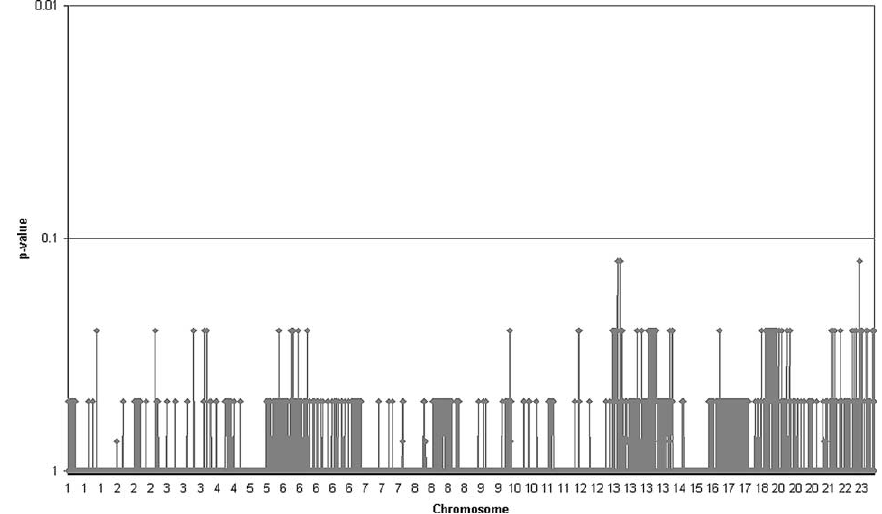
Fig. 3. Graphic view of the p-values obtained in the paired analysis where the two components (intestinal and diffuse) were compared in each tumour.